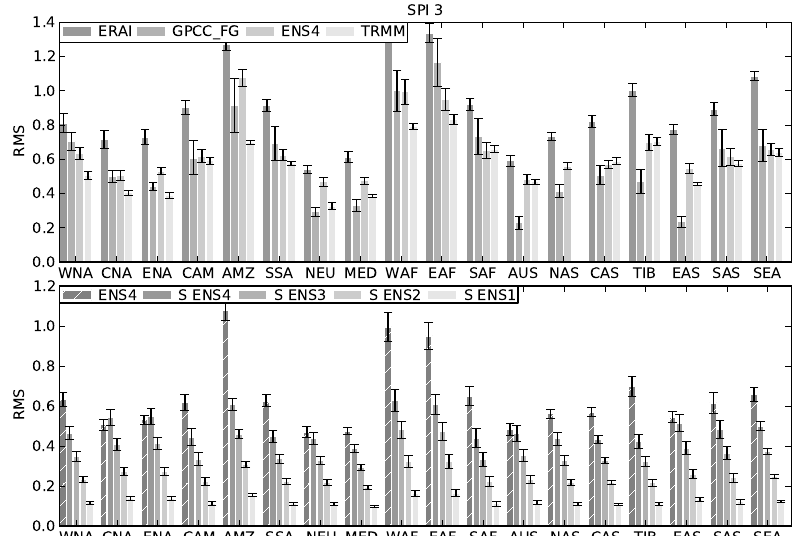
Figure 5. Top: time mean root mean square (RMS) error of the SPI-3 derived from ERAI, GPCC_FG, ensemble mean of ENS4 and TRMM. Bottom: time mean RMS error of the SPI-3 in ENS4 (dashed bars) and the time mean spread about the ensemble mean of ENS4, ENS3, ENS2 and ENS1. The error bars in both panels represent 95% confidence intervals of the temporal mean (monthly values 2009–2012) assuming a normal